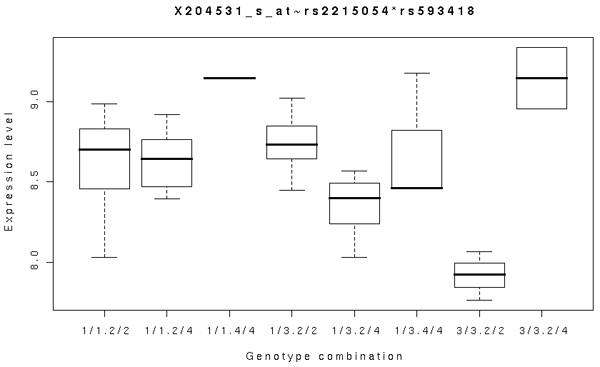
Box plot of the expression of BRCA1 for eachgenotype combination of rs2215054 and rs593418. When the first SNP has 3/3 genotype, the expression level increases as the second genotype is changed from 2/2 to 2/4. When the first SNP has 1/1 or 1/3 genotype the expression level decreases, which illustrates the presence of interaction between the first and second SNPs on the expression levels.